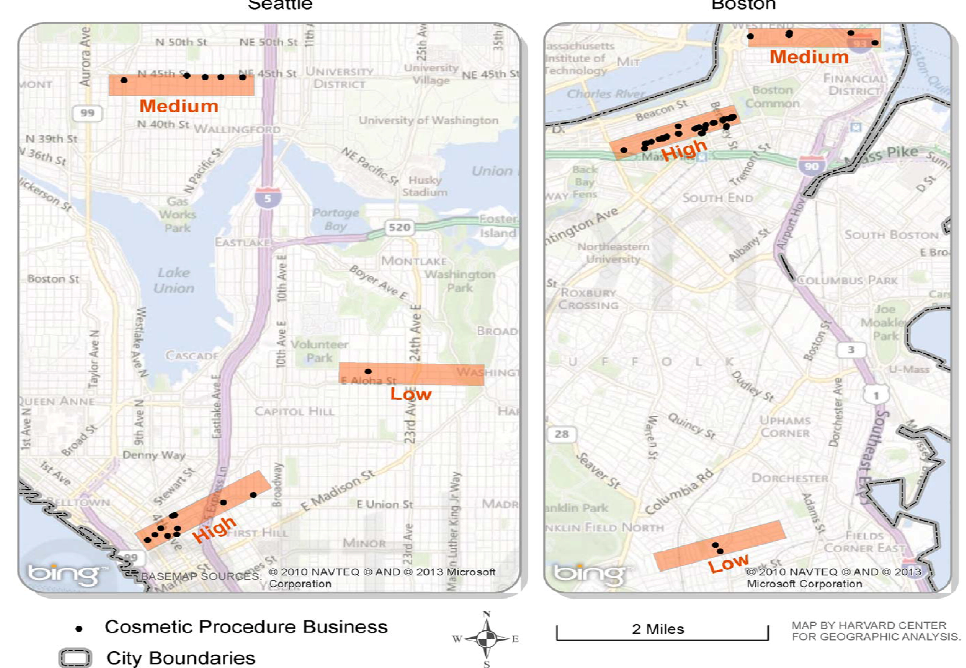
Figure 2. Small-areas validation: Boston and Seattle cosmetic-procedure businesses identified and confirmed in three sub-areas defined by density of